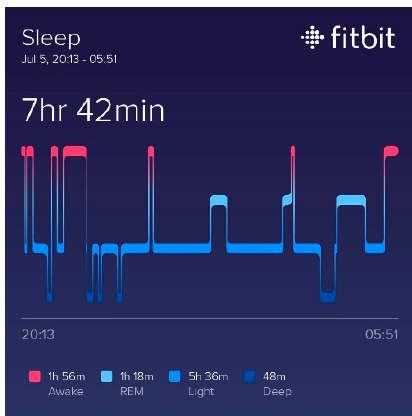
Figure A17. Bangkok, Thailand.